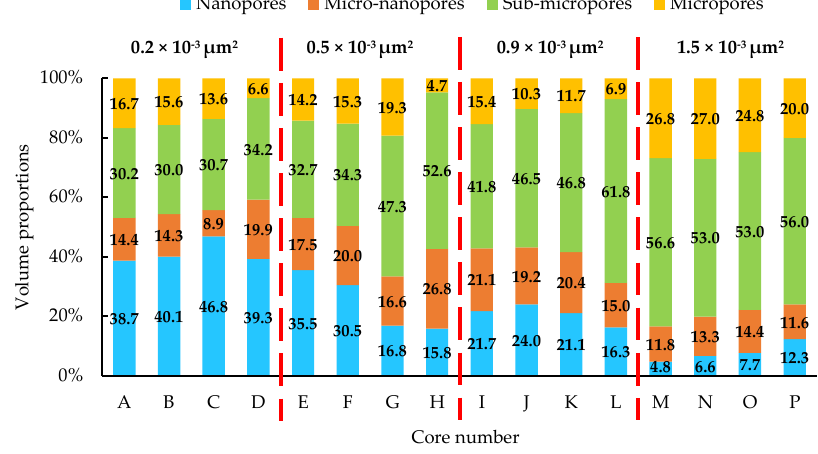
Figure 4. Volume proportions of different pores of tight oil sandstone cores.